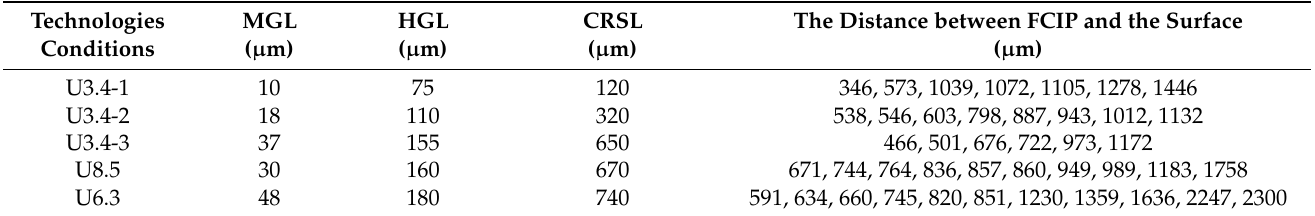
Table 4. Descriptions of the comprehensive influence of the MGFs on the distance between FCIPs and the surface under different